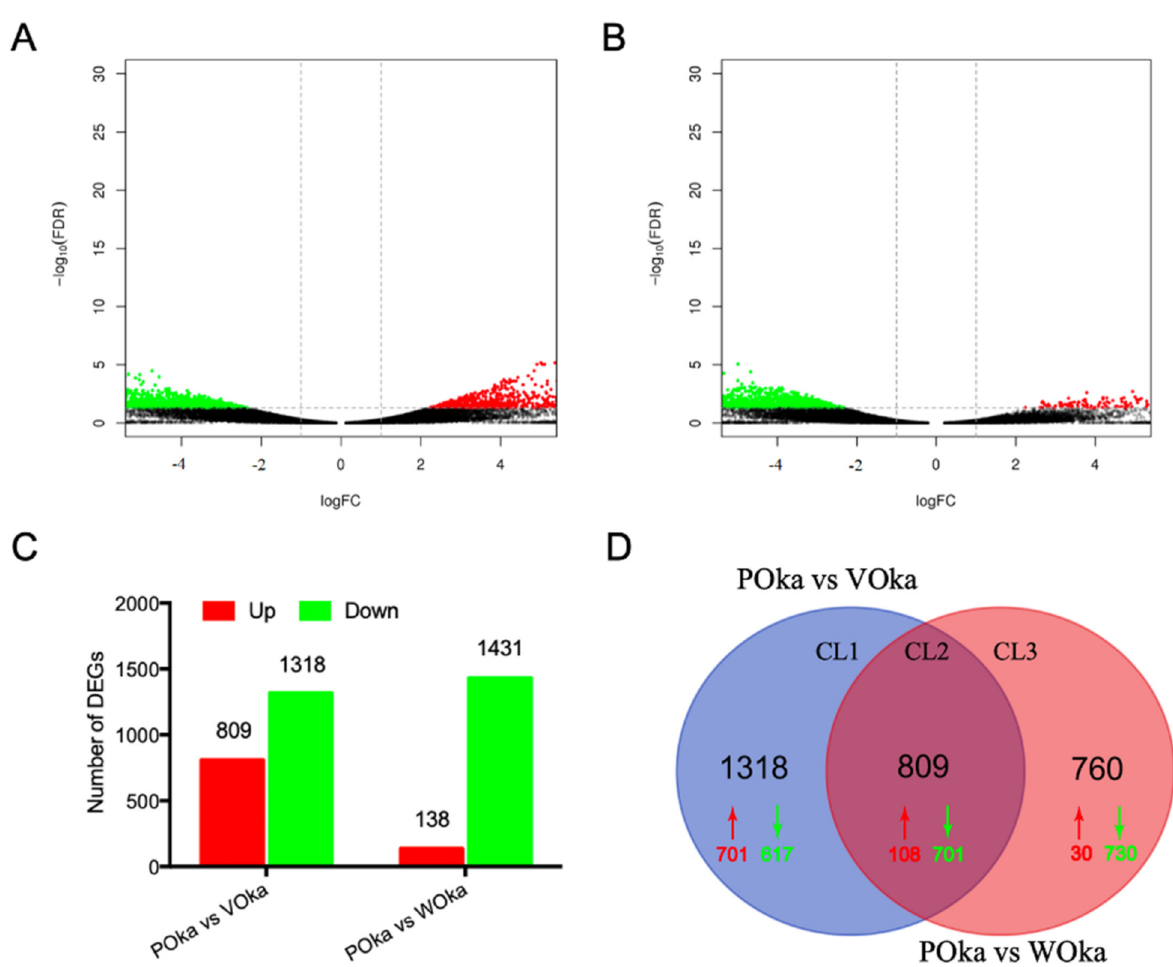
Figure 1. Analysis of the DEGs upon Vp and WSSV challenges. ( A ) Volcano plot displaying DEGs between the VOka group and the POka group. ( B ) Volcano plot displaying DEGs between the WOka group and the POka group. The X axis displays the log of the FC (VOka or WOka group relative to POka group) and the Y axis represents the negative log of the FDR (base 10). Black dots represent genes whose expression levels did not reach statistical significance. ( C ) Statistical results of DEGs between the control group and experimental groups. ( D ) A two-set Venn diagram showing the number of DEGs in different treatments. Upregulated genes are marked with red and downregulated genes are shown in